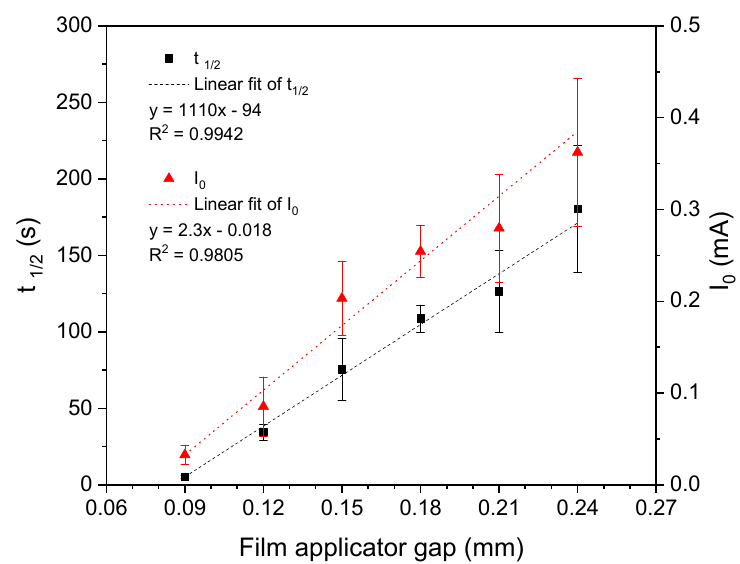
Figure 6. Dependence of the parameter t 1 / 2 and the initial value of current I 0 on film thickness with data points corresponding to mean values and their standard deviation values (error bars) from three experiments.